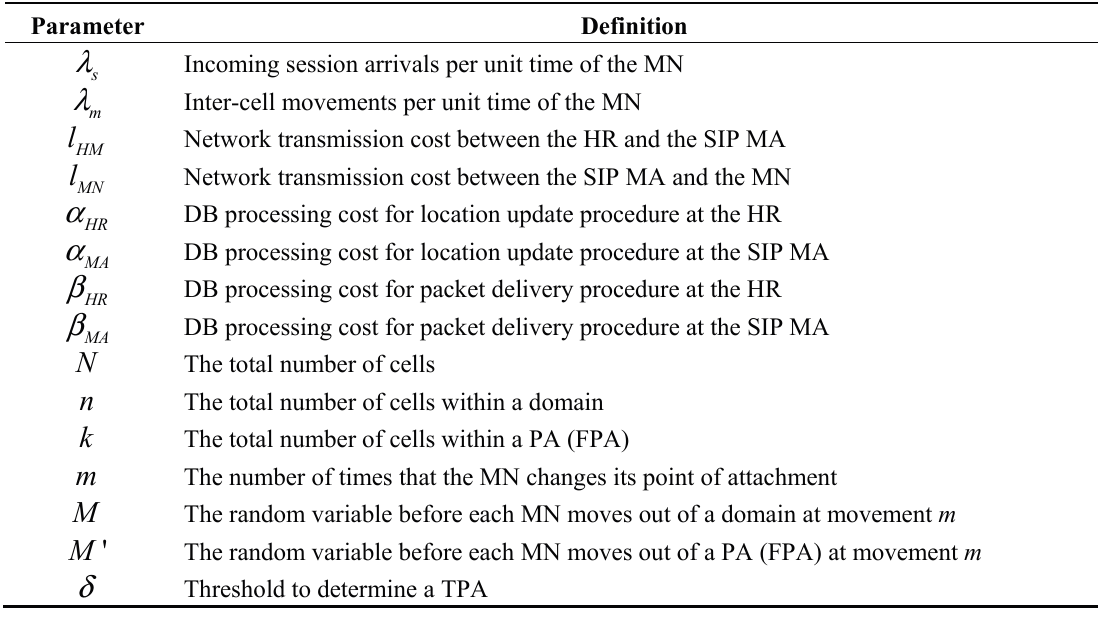
Table 1. Parameters for performance